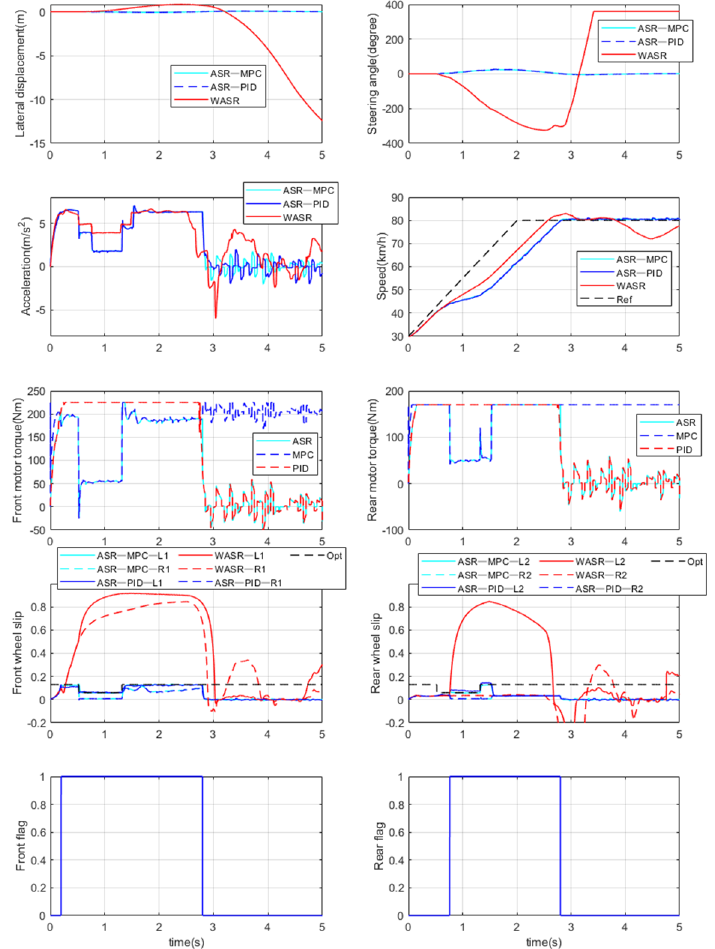
Figure 13. Vehicle accelerates on a split road.